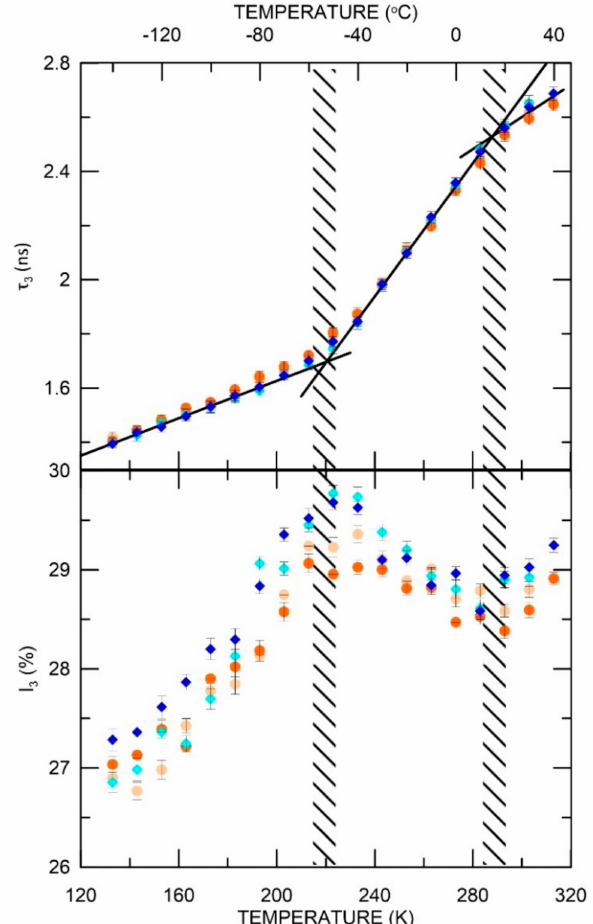
Figure 4. The o-Ps lifetime and intensity as a function of increasing (ELO/PI—orange dots, ELO/10RD1/PI—dark blue diamonds) and decreasing (ELO/PI—creamy dots, ELO/10RD1/PI— light blue diamonds)